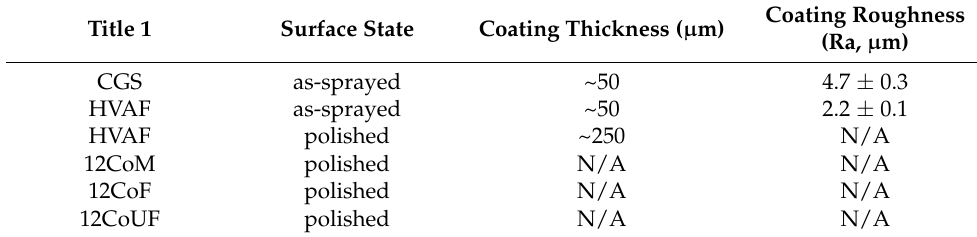
Table 1. Surface conditions of the bulks and coatings’ thicknesses used in the electrochemical